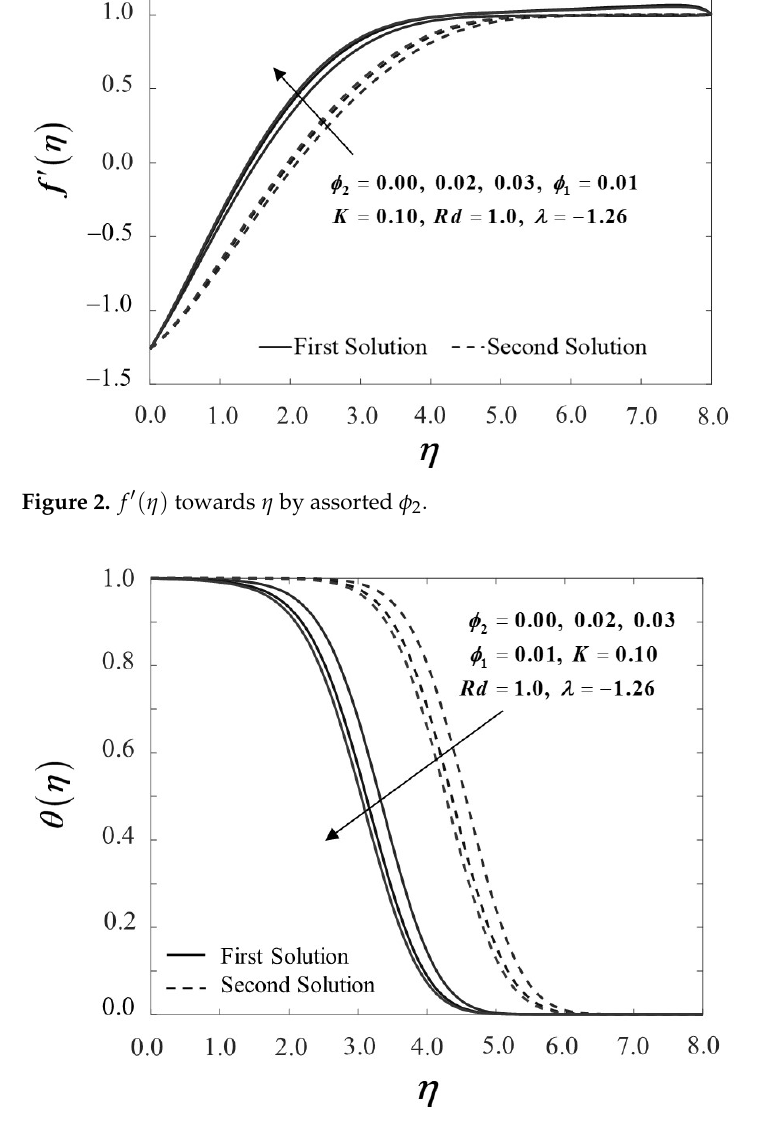
( ) θ η η towards by assorted